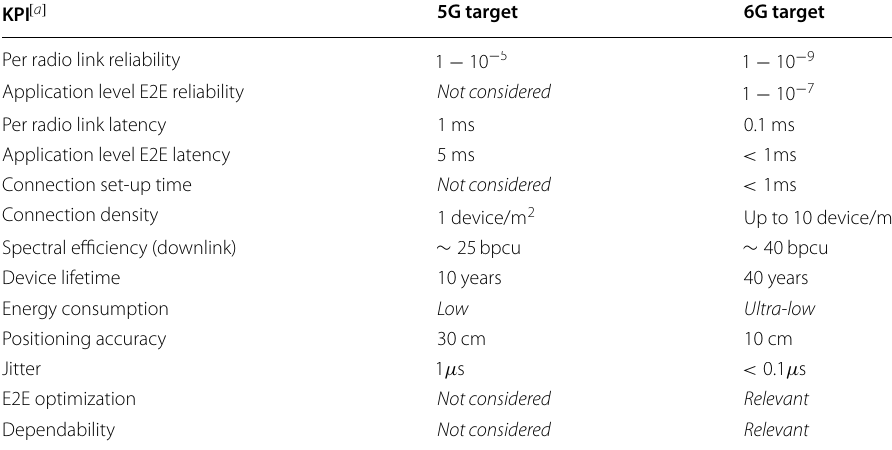
Table 1 A comparison of selected MTC KPIs in 5G and 6G KPI [ a